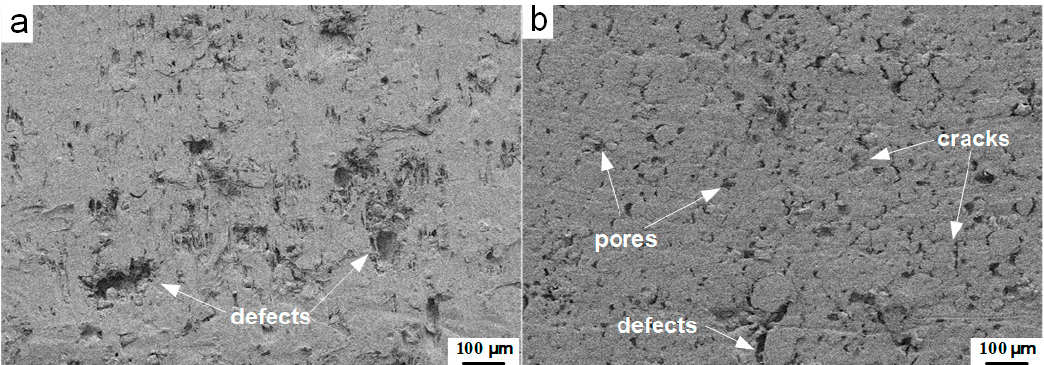
Figure 4. Mesoscale structures of the type C PTFE/Al/W samples pressed under the pressure of 25 MPa: ( a ) hot temperature sintered (HTSed), ( b ) CIPed.